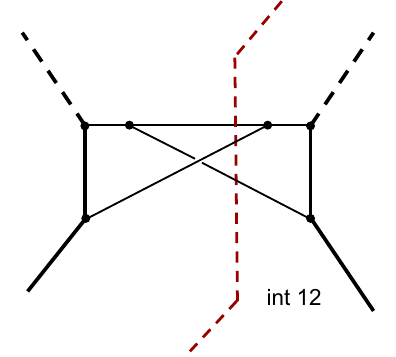
Fig. 4 Additional master integral from Topology C: integral I